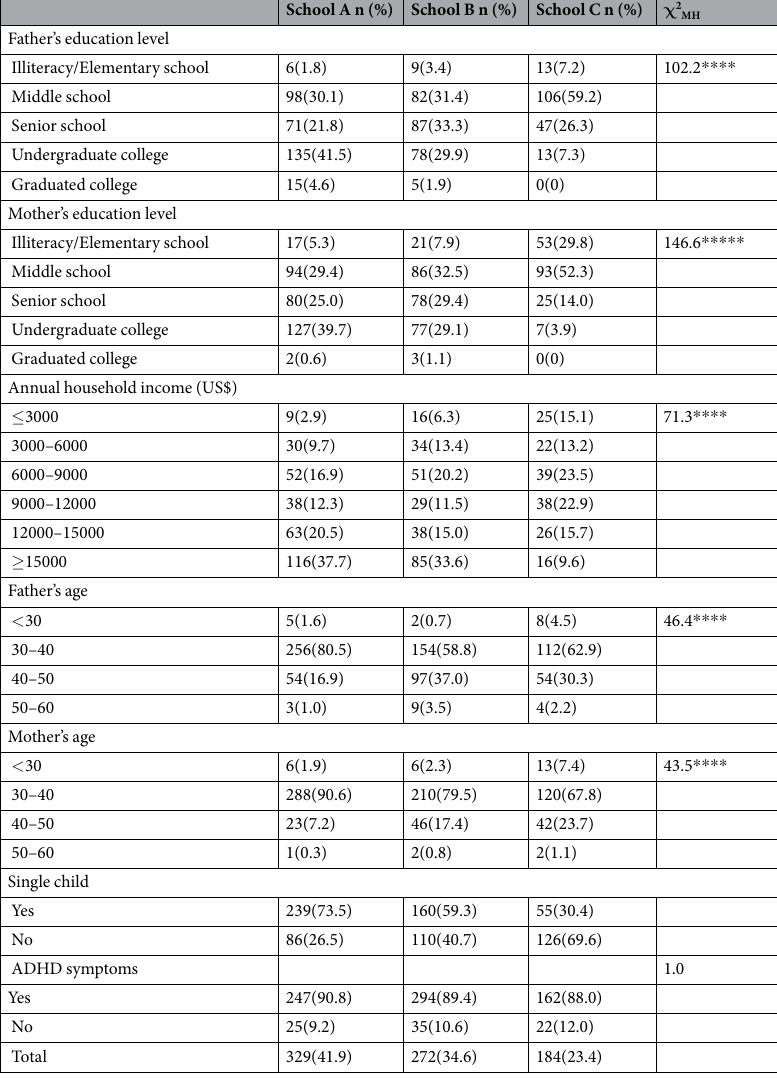
Table 1. The variance in the demographic information of participated families of three elementary schools. **** p < 0.0001 .